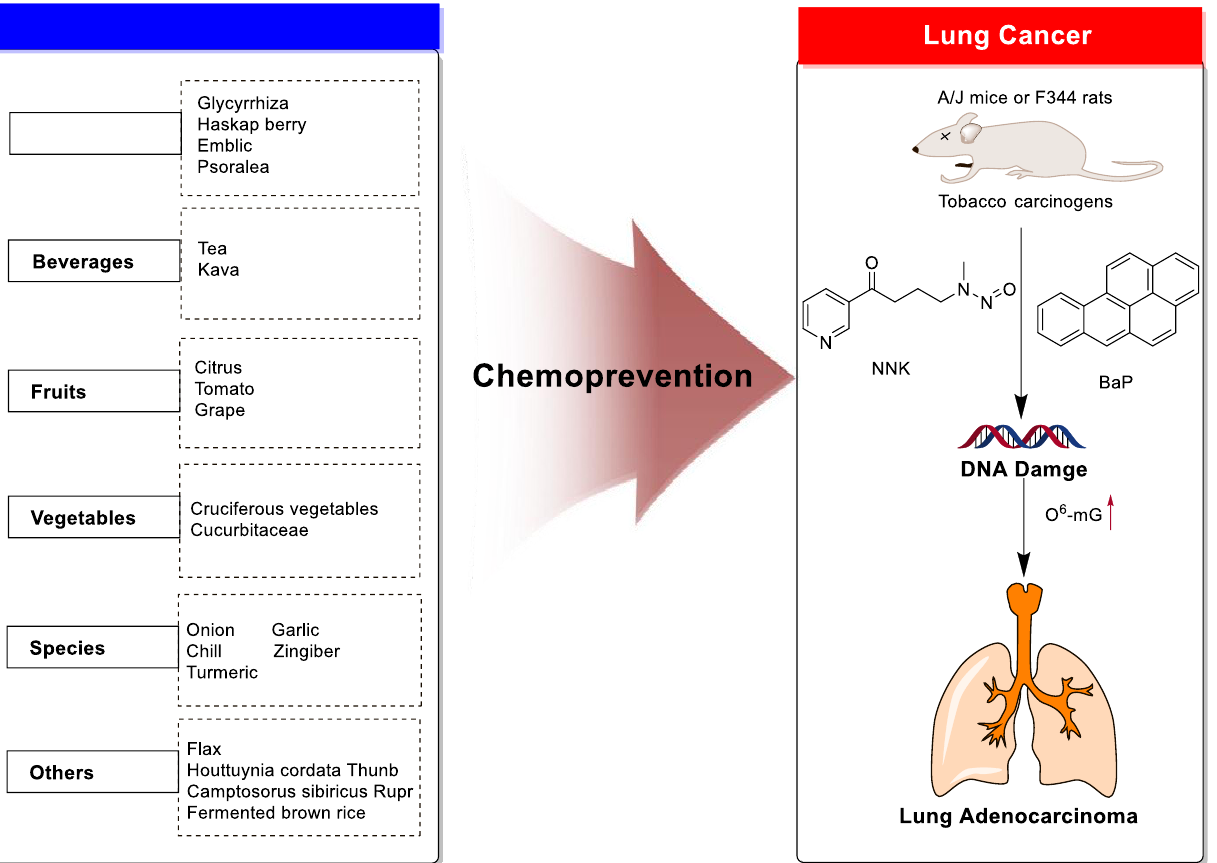
Figure 1. Graphic summary of the dietary phytochemicals that are cancer-preventive on BaP or NNK triggered lung carcinogenesis.